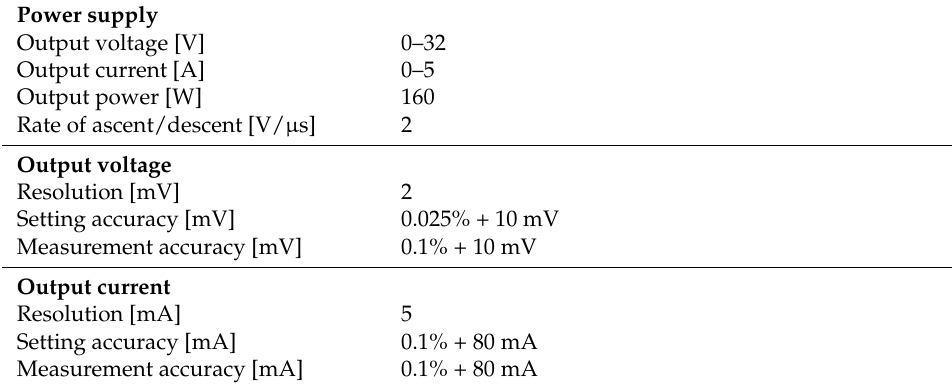
Table 2. Operation data of the power supply Toellner